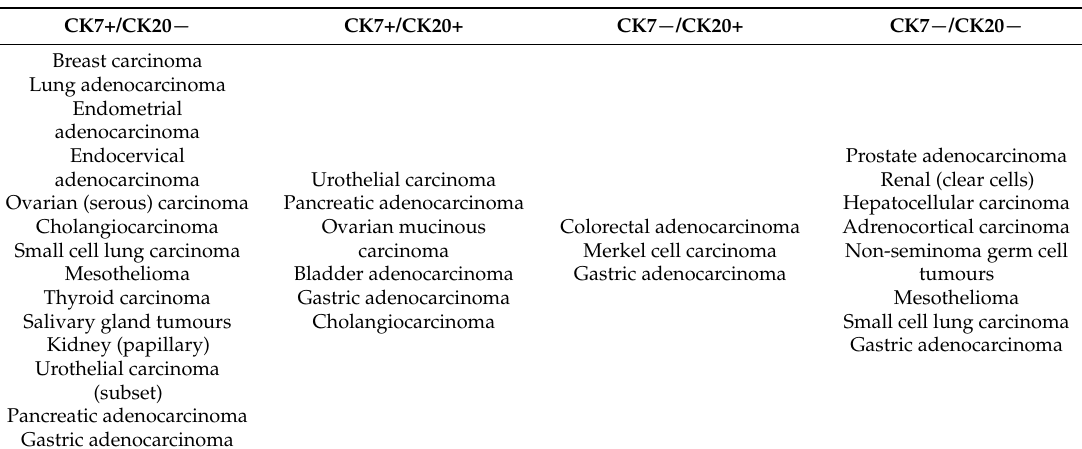
Table 1. Main primary origins of carcinomas of unknown primary site (CUPs) based on staining for CK7 and CK20